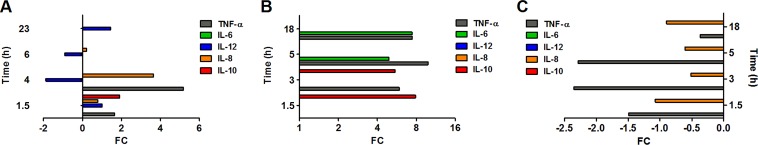
Schematic summary of the cytokines released by THP-1 cells (A), human PBMCs (B), and human MDMs (C) after coincubation with Acanthamoeba trophozoites. During coincubation with trophozoites of Acanthamoeba, human monocytes (THP-1 cells and PBMCs) produced IL-10 from the earliest time points only for a short period of time; subsequently it produced TNF-α and IL-8. In contrast, trophozoites induced a particular decrease of IL-8 and TNF-α in human macrophages.